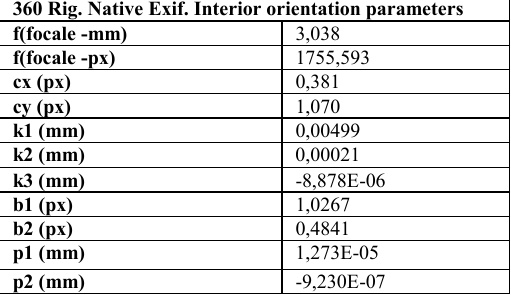
Table 3. Estimated interior orientation parameters of the six cameras mounted on the rig and automatically processed with the native Exif